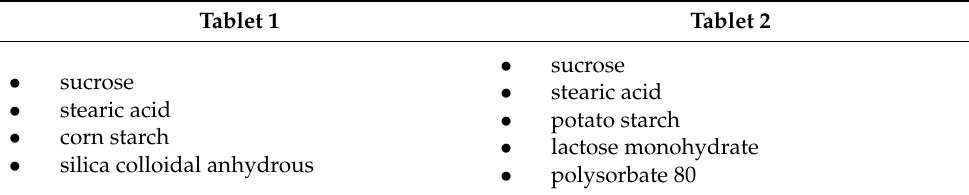
Table 2. Excipients used in the tested